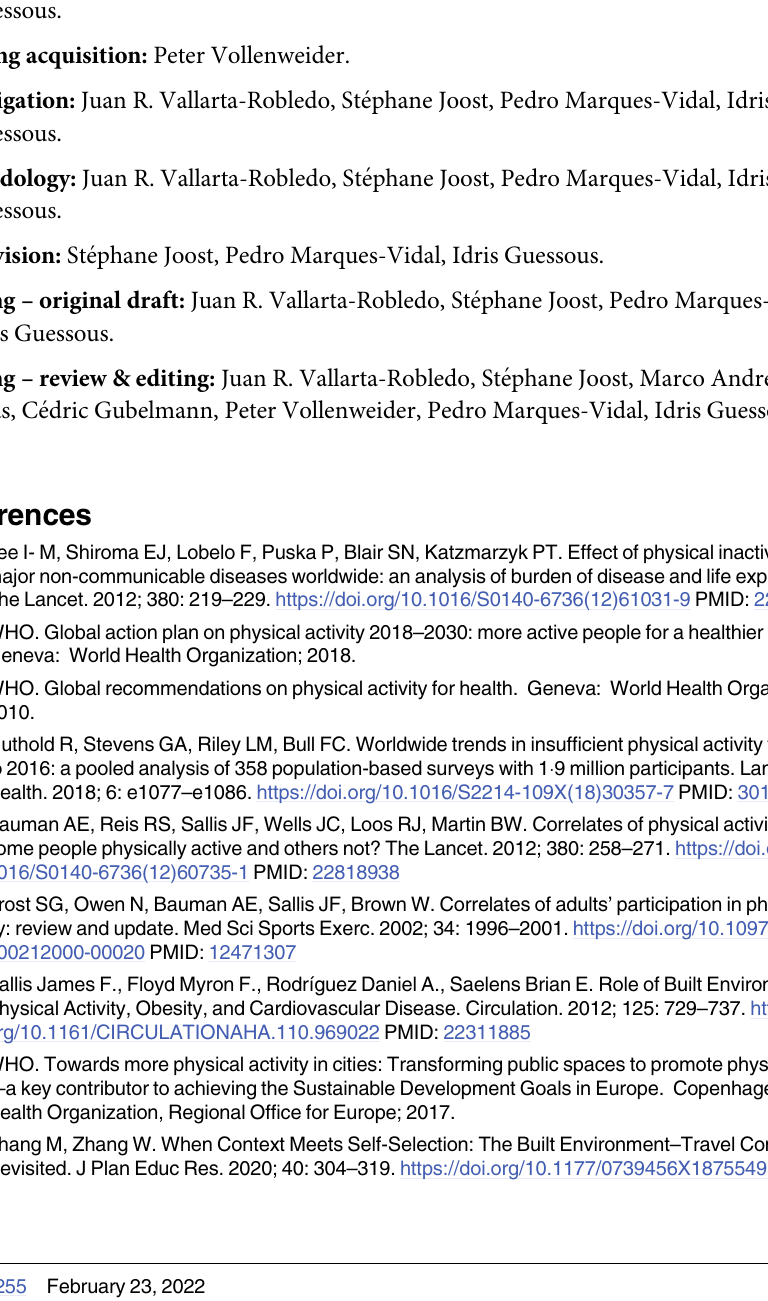
S3 Table. Population socioeconomic and demographic characteristics of adjusted MVPA spatial